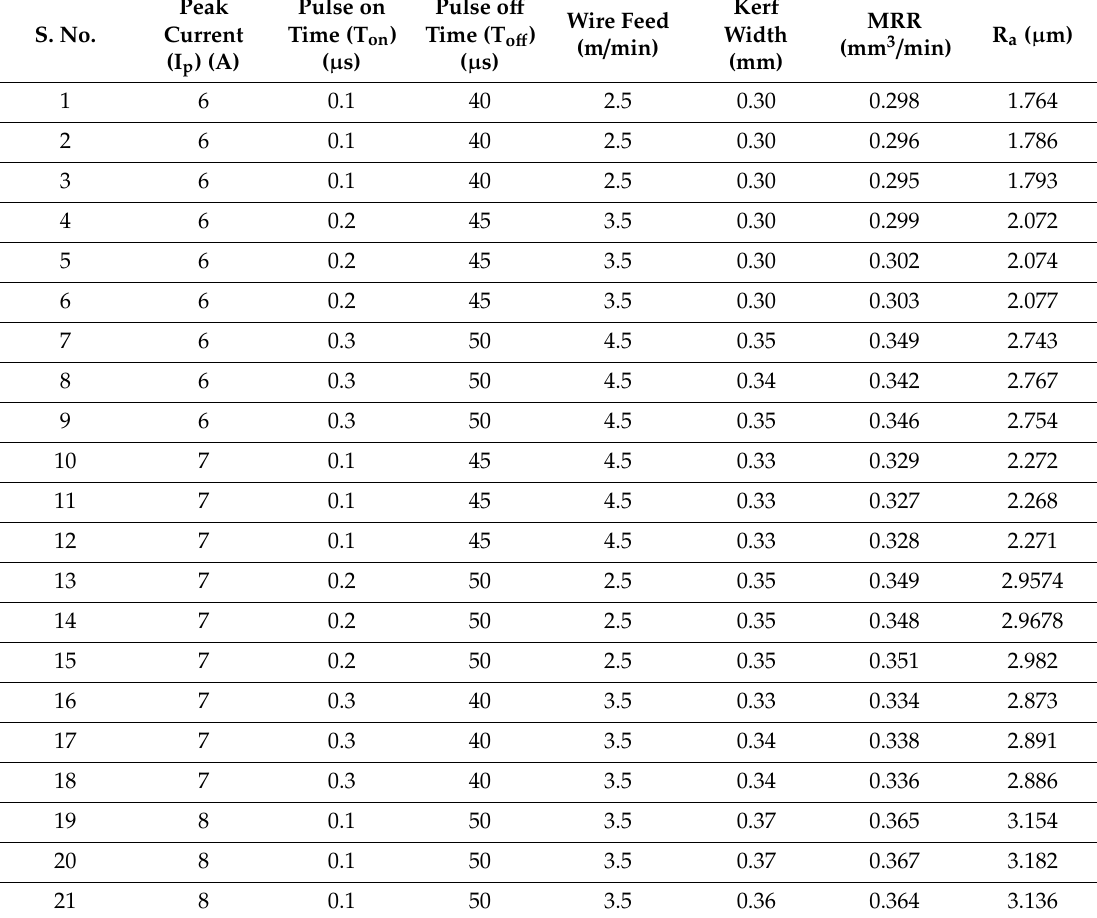
Table 7. L 27 orthogonal array for wire electrical discharge cutting of the Al-SiC-TiC metal matrix composite under an oil + para ffi n + wax dielectric